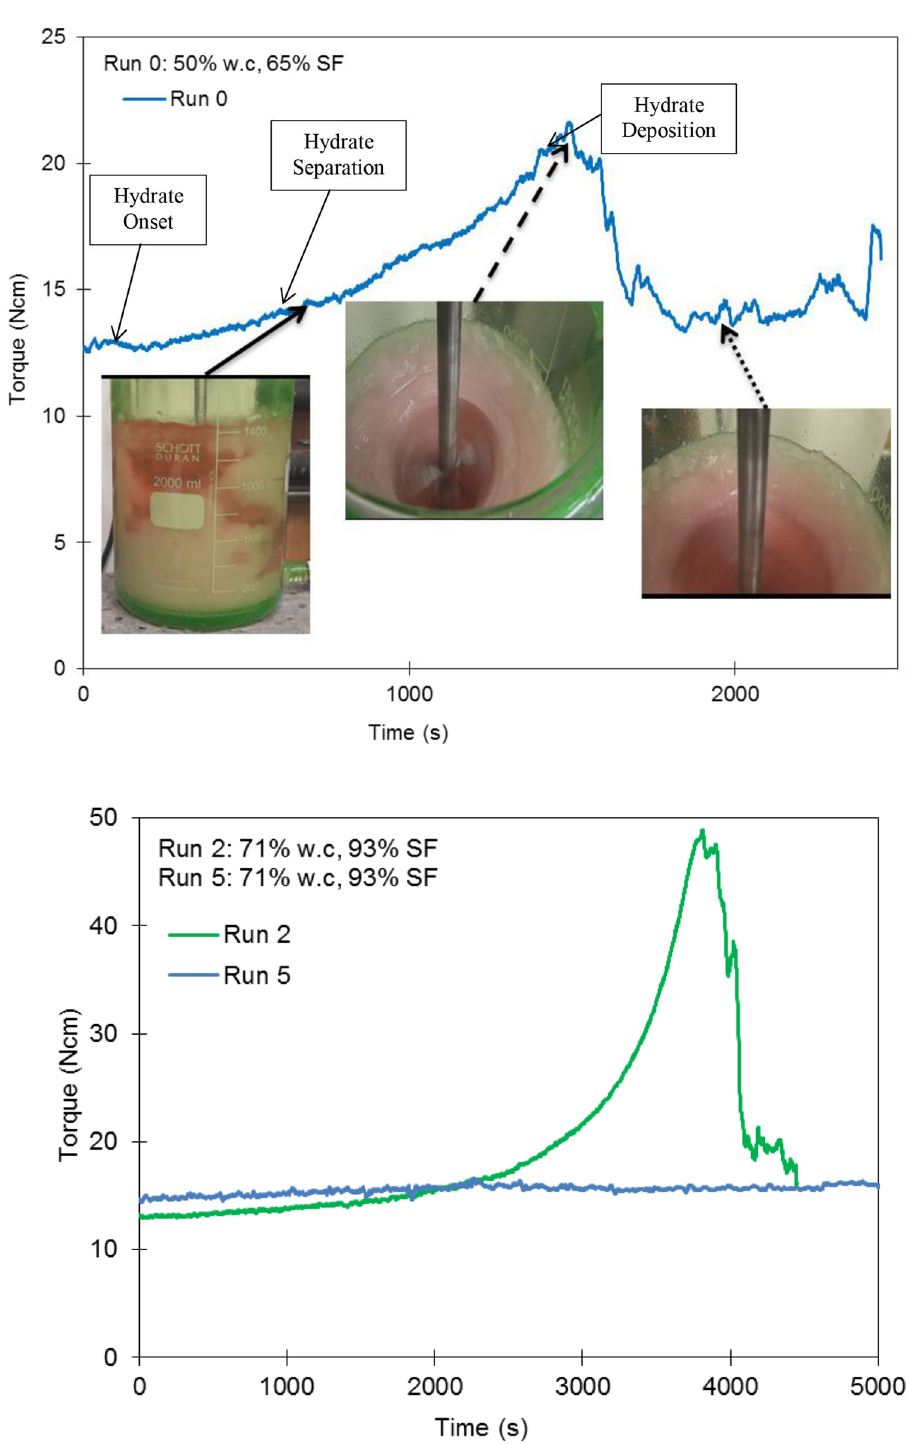
Fig. 3 Visual observation of cyclopentane hydrate mixture with time. W.C watercut, SF solid fraction